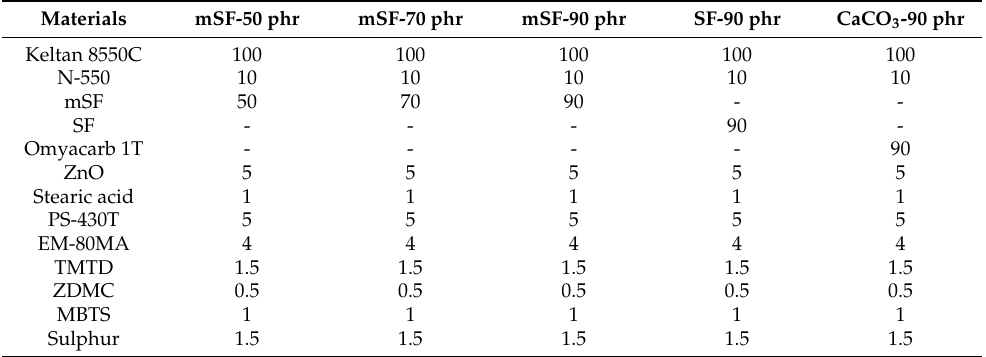
Table 1. Formulations of EPDM